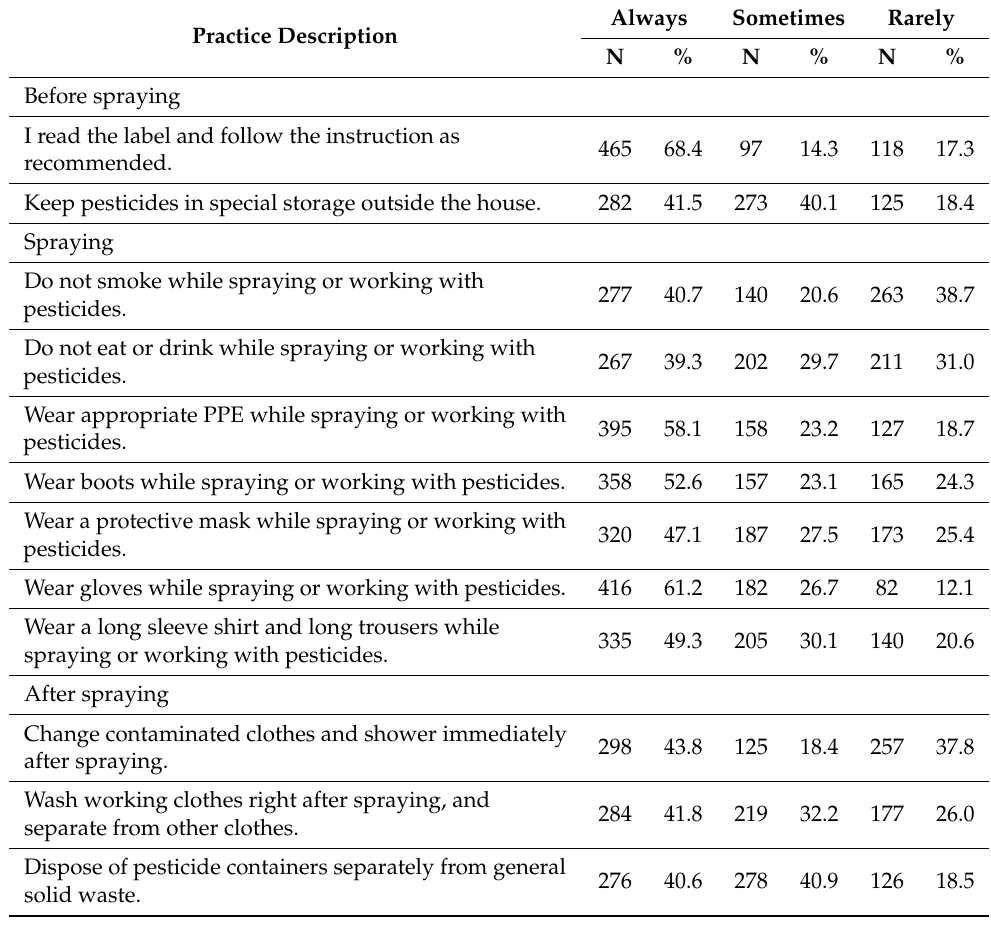
Table A3. Pesticide use practices among farmers in Nakhon Sawan (N = 680). Practice